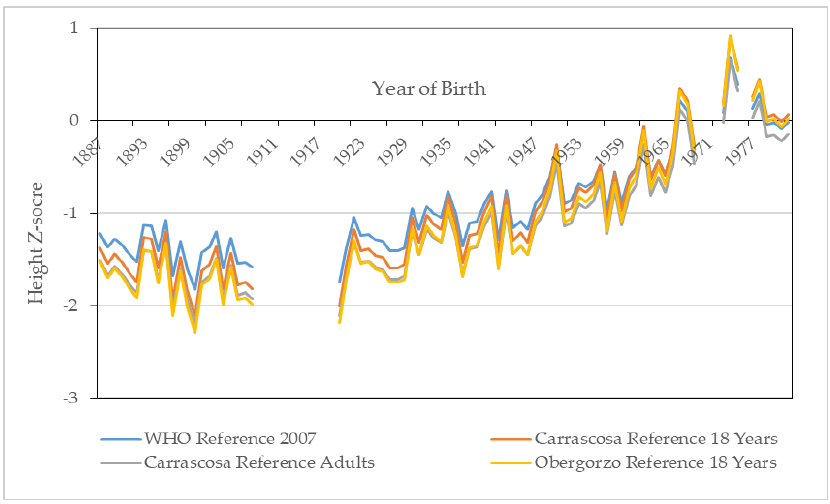
Figure 8. Annual height z-scores (HAZ). Source: AMSB, ACDS. Own work.